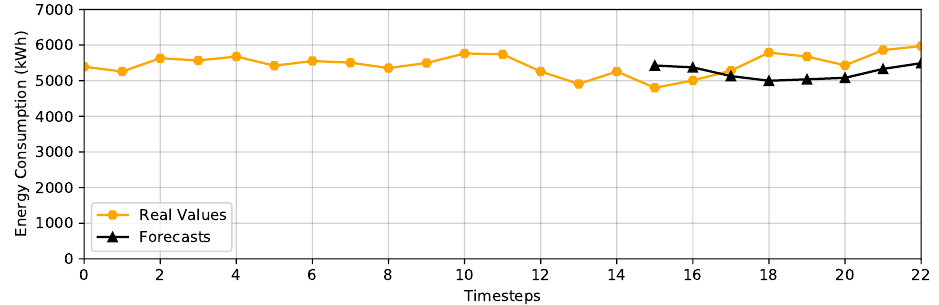
Figure 10. Eight multi-step forecasts when re-train the entire